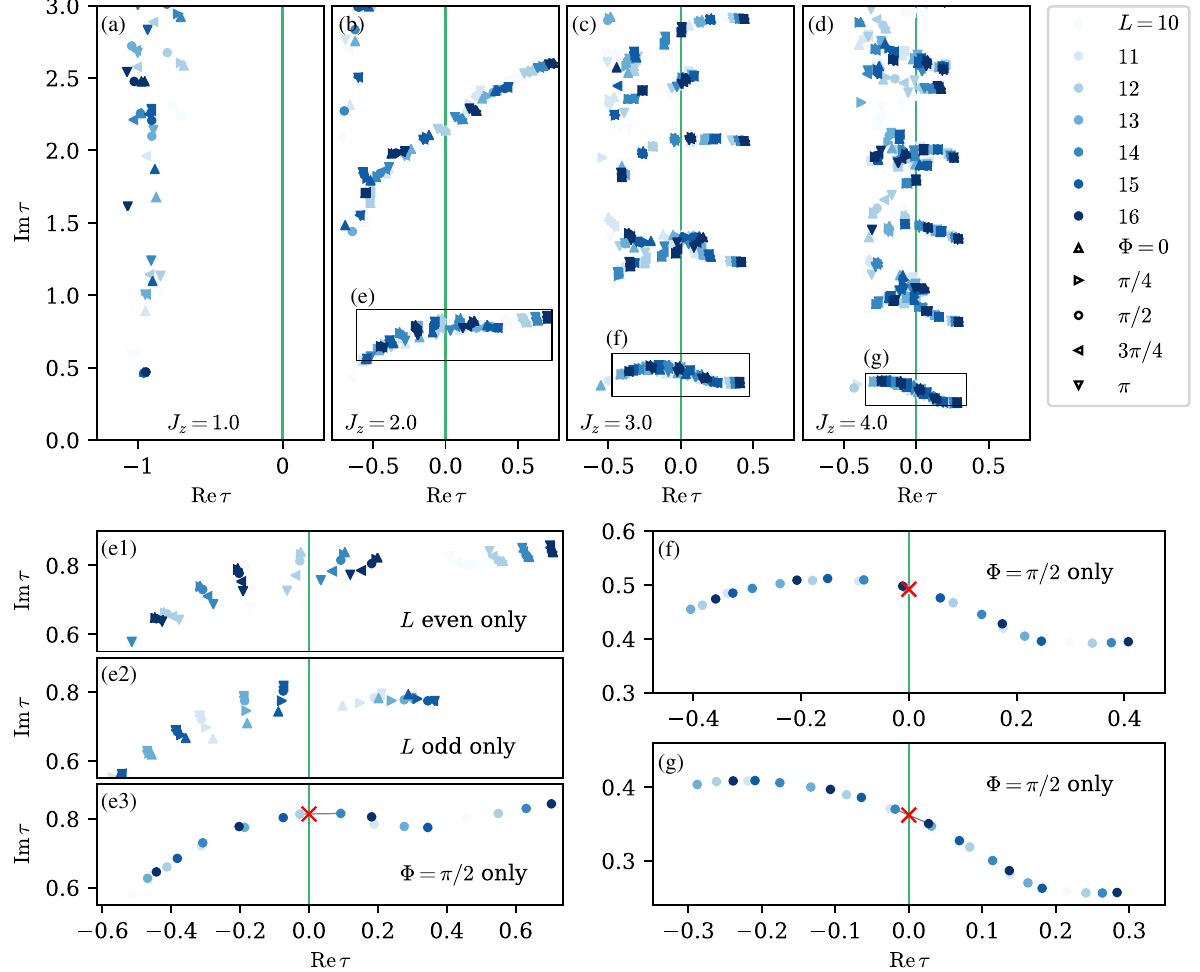
FIG. 4. Quench from the Haldane phase to the N´eel phase. The initial state is the ground state of the model (11) with J z =J ¼ 1 = 2 and D ¼ B ¼ 0 . The quench is performed by changing the parameter J J 1 , 2, 3, 4 (in units of J ). (a) Loschmidt zeros for z to the values z ¼ the quench to J z ¼ 1 , which is not sufficiently large to reach the N´eel phase. In this case, the zeros do not cross the imaginary axis, and no dynamical phase transition occurs. (b) – (d) Similar to panel (a), but with J z ¼ 2 , 3, 4. In this case, several dynamical phase transitions occur as shown, for example, in panels (e1) – (e3), (f), and (g). The critical times are shown as red crosses and are estimated as done in Fig. 3 using the zeros for Φ ¼ π = 2 only (see Appendix D for